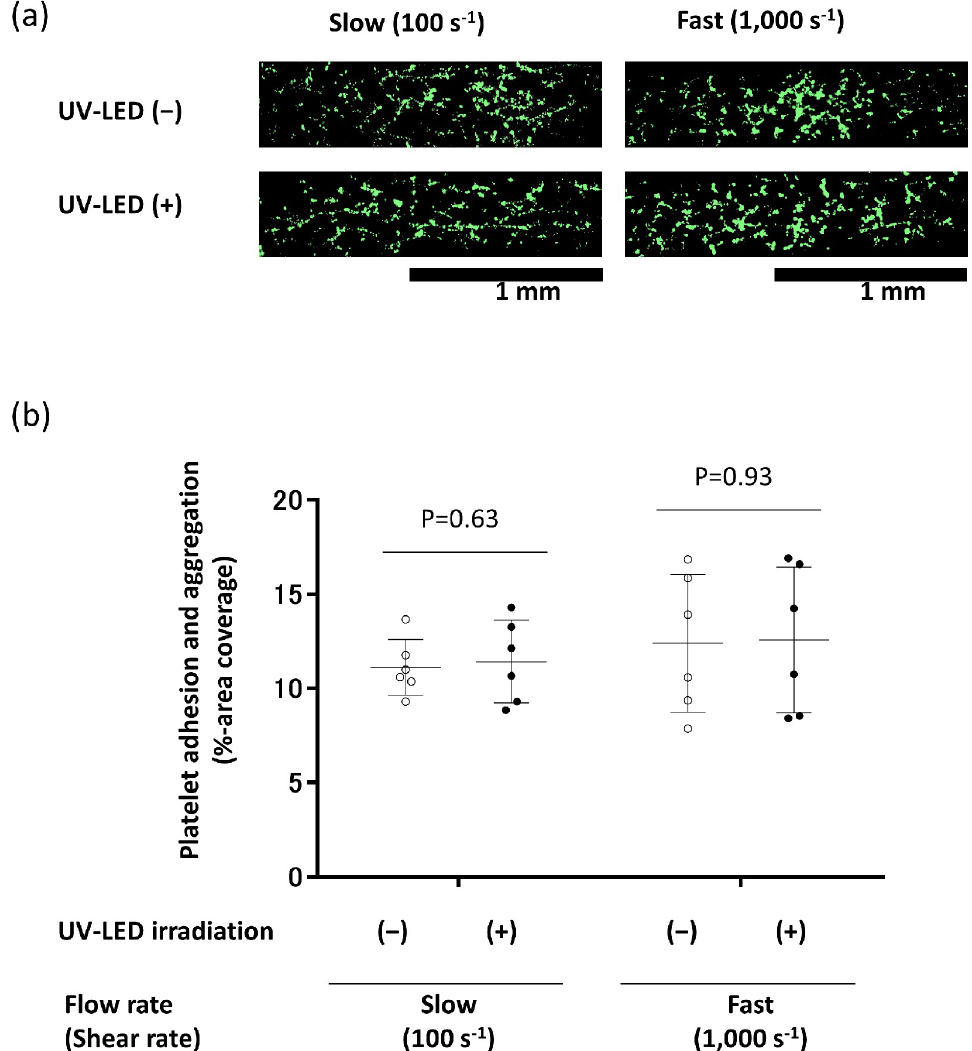
Fig 6. Effect of UV-LED irradiation on adhesion and aggregation to collagen under flow conditions. PCs were irradiated with UV-LED for 30 min. Non-irradiated (UV-LED ( − )) and UV-LED-irradiated (UV-LED (+)) platelets were loaded using low (100 s -1 ) and high (1,000 s -1 ) shear rates, and images were obtained after 5 and 2 min of flow, respectively. (a) Representative images from six independent experiments are shown. (b) Six independent experiments of control (non-irradiated, (( − )) and UV-LED-irradiated (+) samples are displayed as open and closed circles, respectively. Mean values ± SD are shown as one long and two short horizontal bars. In Table 2, we summarize our results and those of three other groups who investigated UVC inactivation of PCs using different UV light sources. Briefly, two groups used platelet additive solution (PAS)-PCs with 10 or 35% plasma concentrations, whereas the remaining two including ours used original (non-PAS) PCs. Two used open petri dishes and the other two used closed bags. The intensity of our 265 nm UV-LED (1.05 mW/cm 2 ) was in between two others (0.25 and 7~8 mW/cm 2 ). The differences come partly from the differences in the distance between the light source and the target objects and depth of the objects. Of note, the relative transparency of PCs under UVC irradiation is an important factor in improving disin- fection efficiency and reducing processing time. For this purpose, Terpstra et al. used an